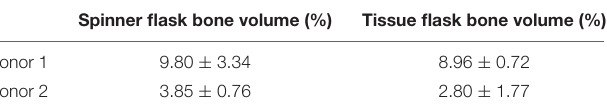
TABLE 5 | Bone percentages analyzed from CT scans of cells implanted on NuOss scaffolds after 8 days of expansion on spinner flasks compared to cells only expanded in tissue